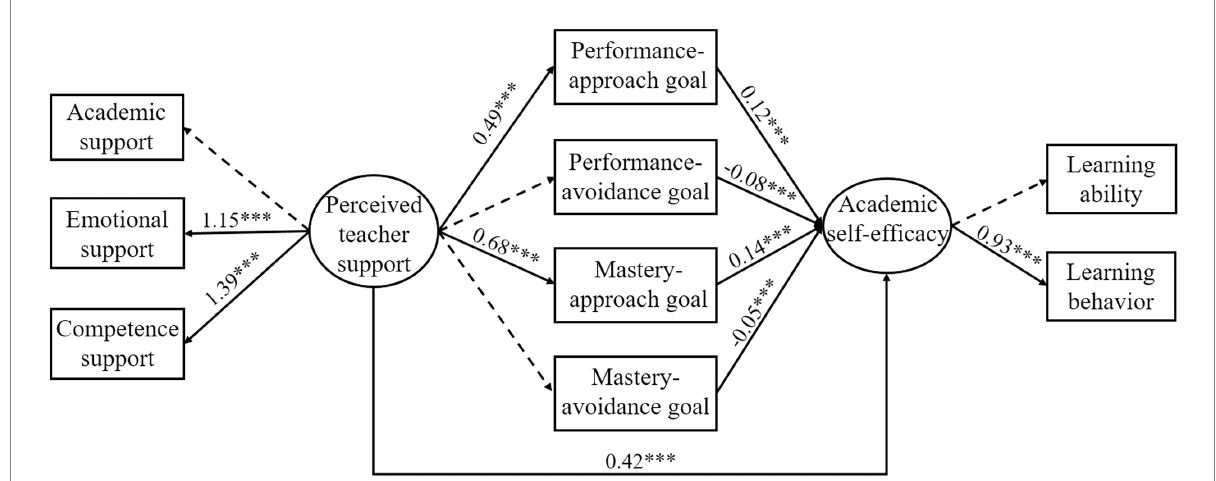
FIGURE 1 SEM of achievement goals as the mediators. The coefficients shown are standardized path coefficients. A solid arrow represents a significant path, and a dotted arrow represents an insignificant path (*** p < 0.001).